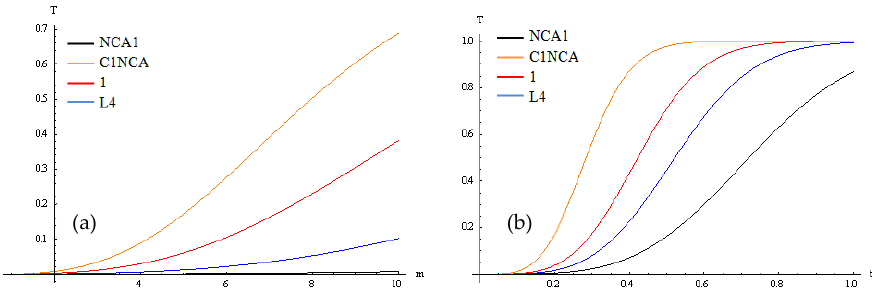
Figure 4. The multifractal transparency variation, in a two-dimensional representation, for energy ratio m ( a ) and time t ( b ) and for t = const . and m = const ., respectively.